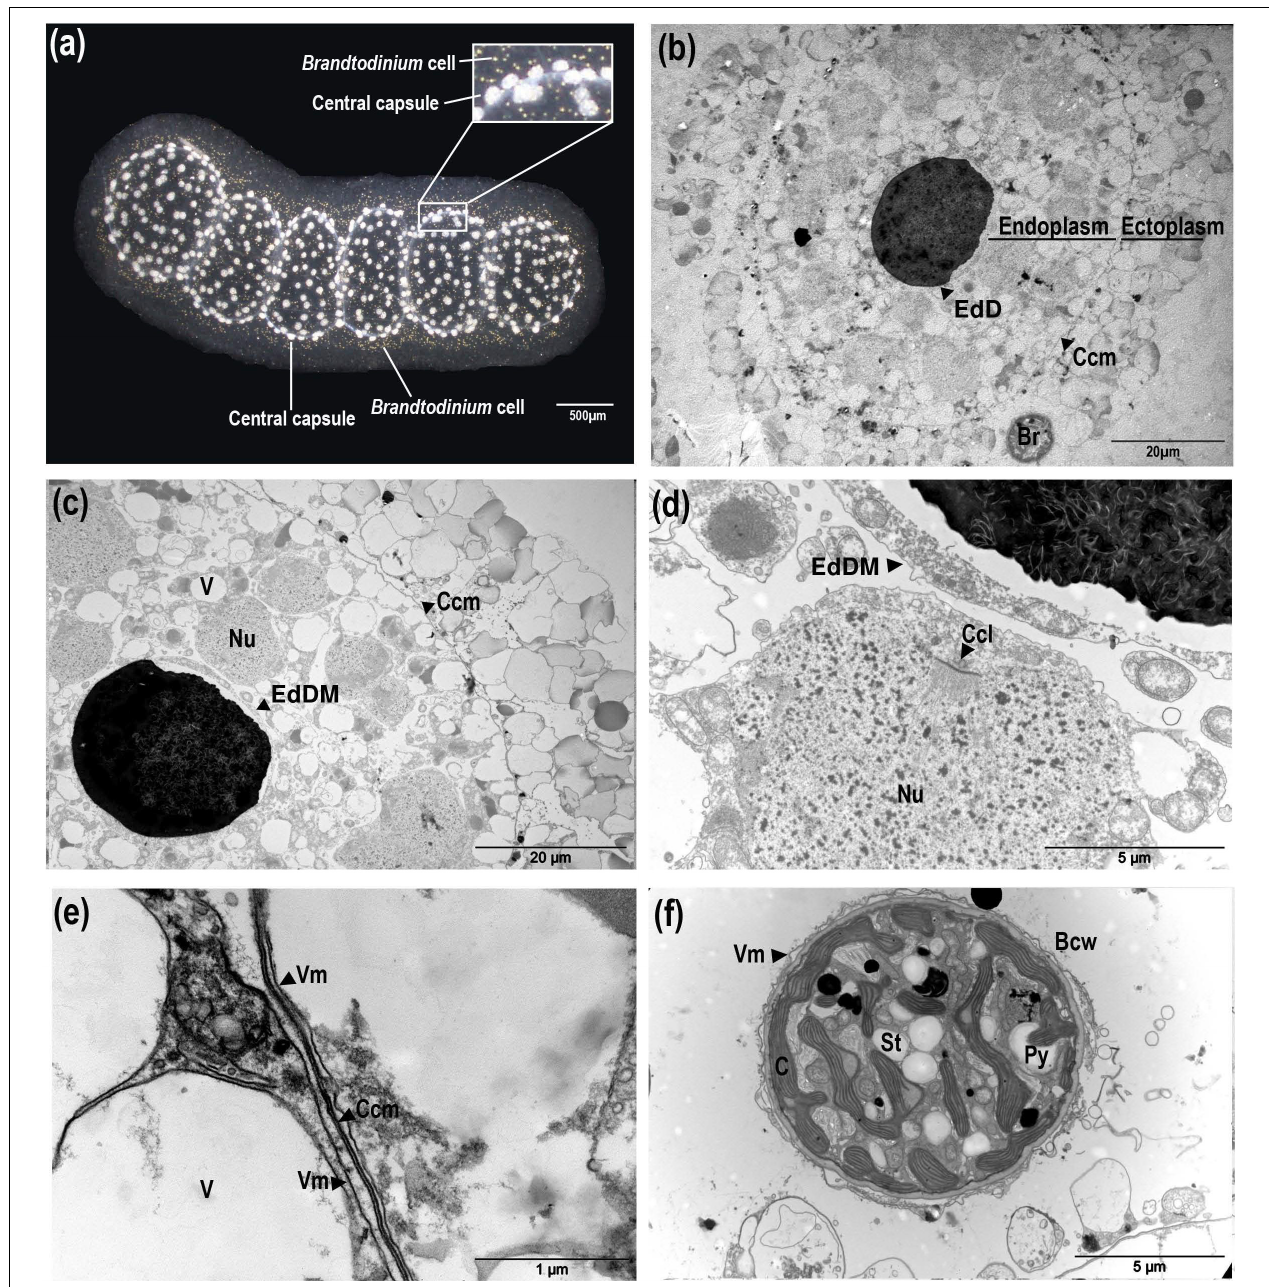
FIGURE 1 | Description of Collozoum pelagicum morphology and ultrastructure. Collozoum pelagicum colony morphological aspect by binocular observation (a) . Observation of the general organization of a central capsule observed by Transmission Electron Microscopy (b,c) . Focus on nuclei in the endoplasm of the central capsule (d) , membranes at the periphery of the central capsule (e) and in hospite Brandtodinium nutricula cells (f) , observed by electron microscopy. Bcw, B. nutricula cell wall; C, Chloroplast; Ccl, cord-like Chromatin; Ccm, Central capsule membrane; EdD, Electron-dense Droplet; EdDM, Electron-dense Droplet Membrane; Nu, Nuclei; Py, Pyrenoid; St, Starch granule; V, Vacuole; Vm, Vacuolar